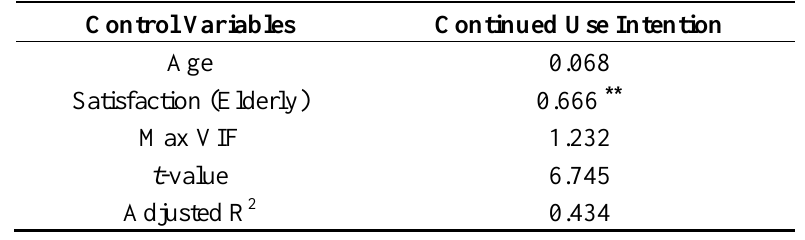
Table 3. Older peoples’ satisfaction and the continued use intention.